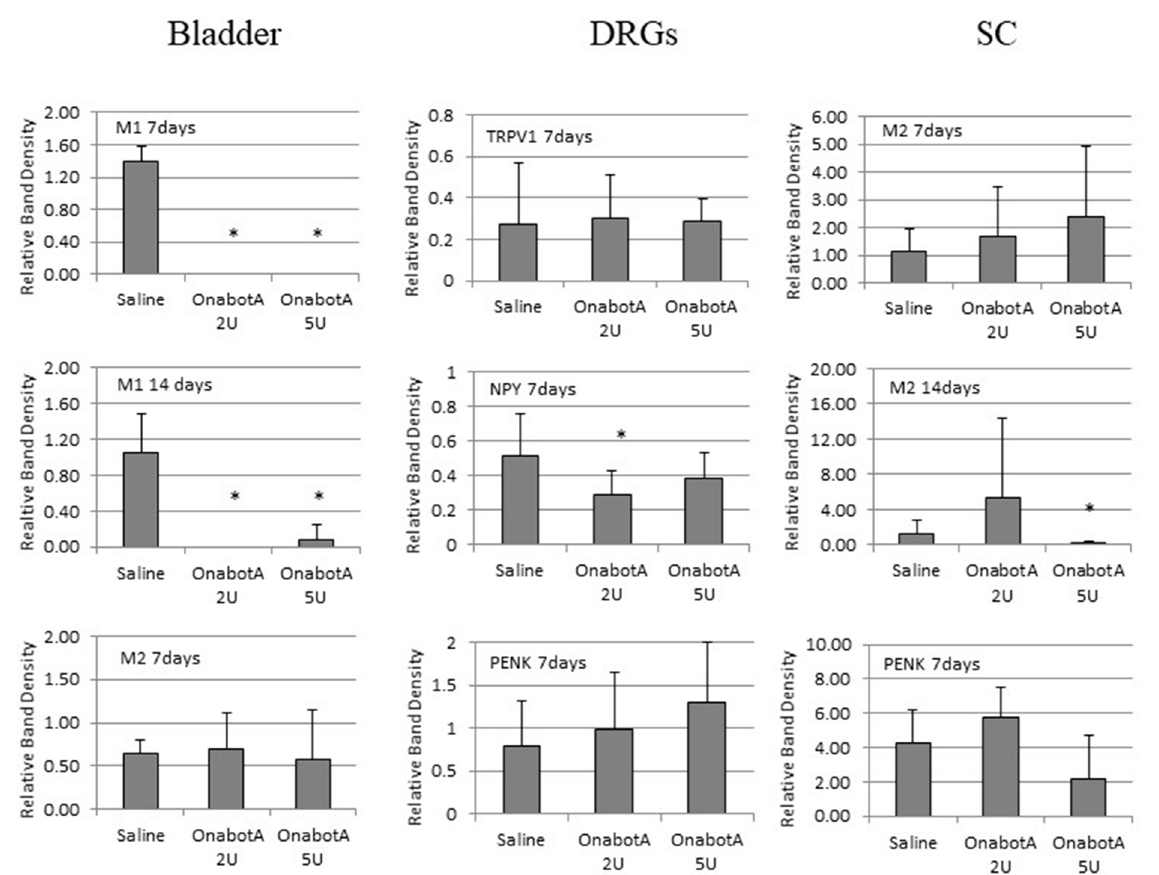
Figure 5. Quantified relative band density of proteins in the bladder, DRG (dorsal root ganglia) and SC (spinal cord) of saline-treated (7 days post-treatment, n = 5; and/or 14 days post-treatment, n = 5) and OnabotulinumtoxinA-treated rats (7 days post-treatment, n = 5; and/or 14 days post-treatment, n = 5). Band densities were normalized to a reference sample loaded onto all gels and measured relative to actin band density. Error bar: standard deviation. *: statistically significant difference ( p < 0.05) with respect to saline.